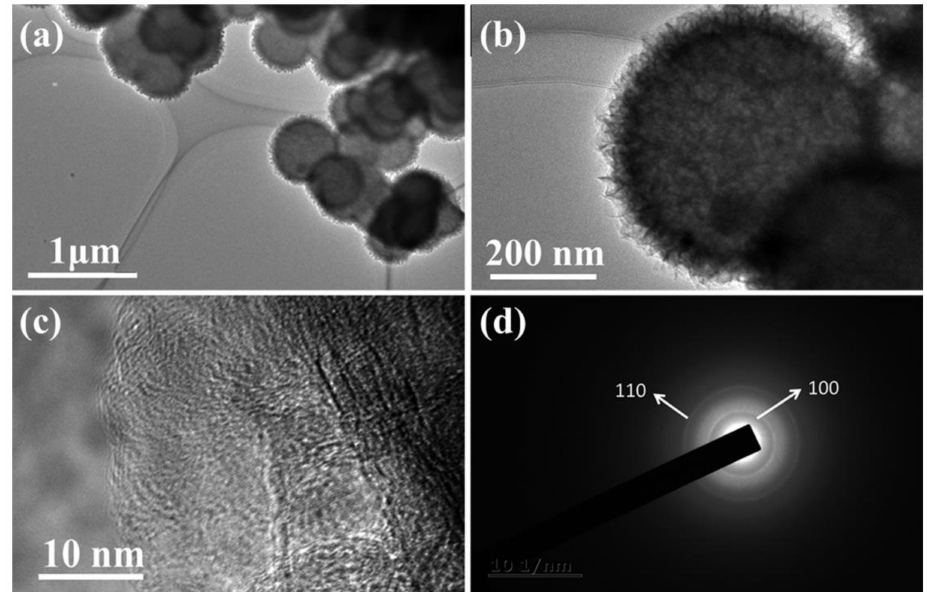
Figure 4. Transmission electron microscope (TEM) images of ( a – c ) MoS 2 /C-2 microspheres at different magnifications; ( d ) electron diffraction pattern of MoS 2